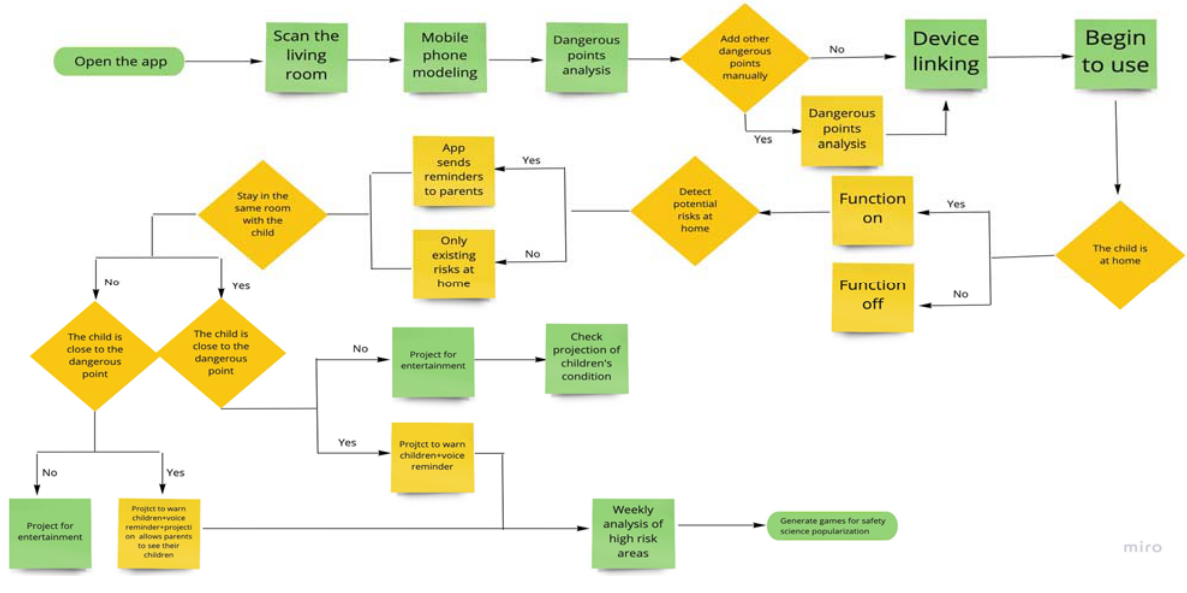
Figure 5. The HCI logic diagram.